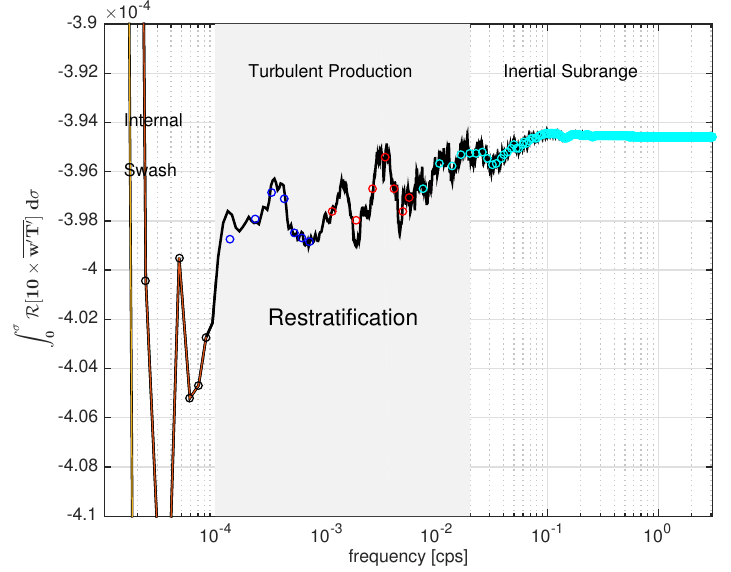
Figure 16. Running integral of the vertical temperature flux from the previous panel, with emphasis on the turbulent production region of frequency space. In this frequency band, the fluxes are upgradient, i.e.,